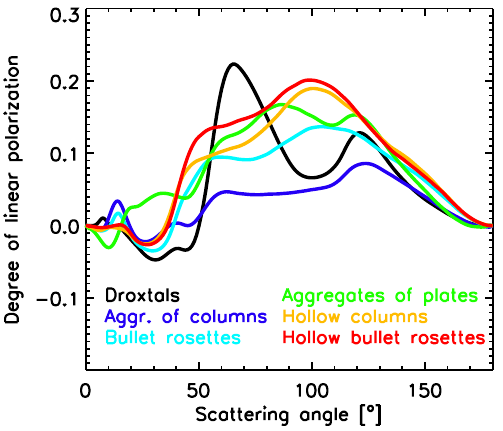
Fig. 3. Similar to Fig. 2 but for various moderately roughened com- plex ice